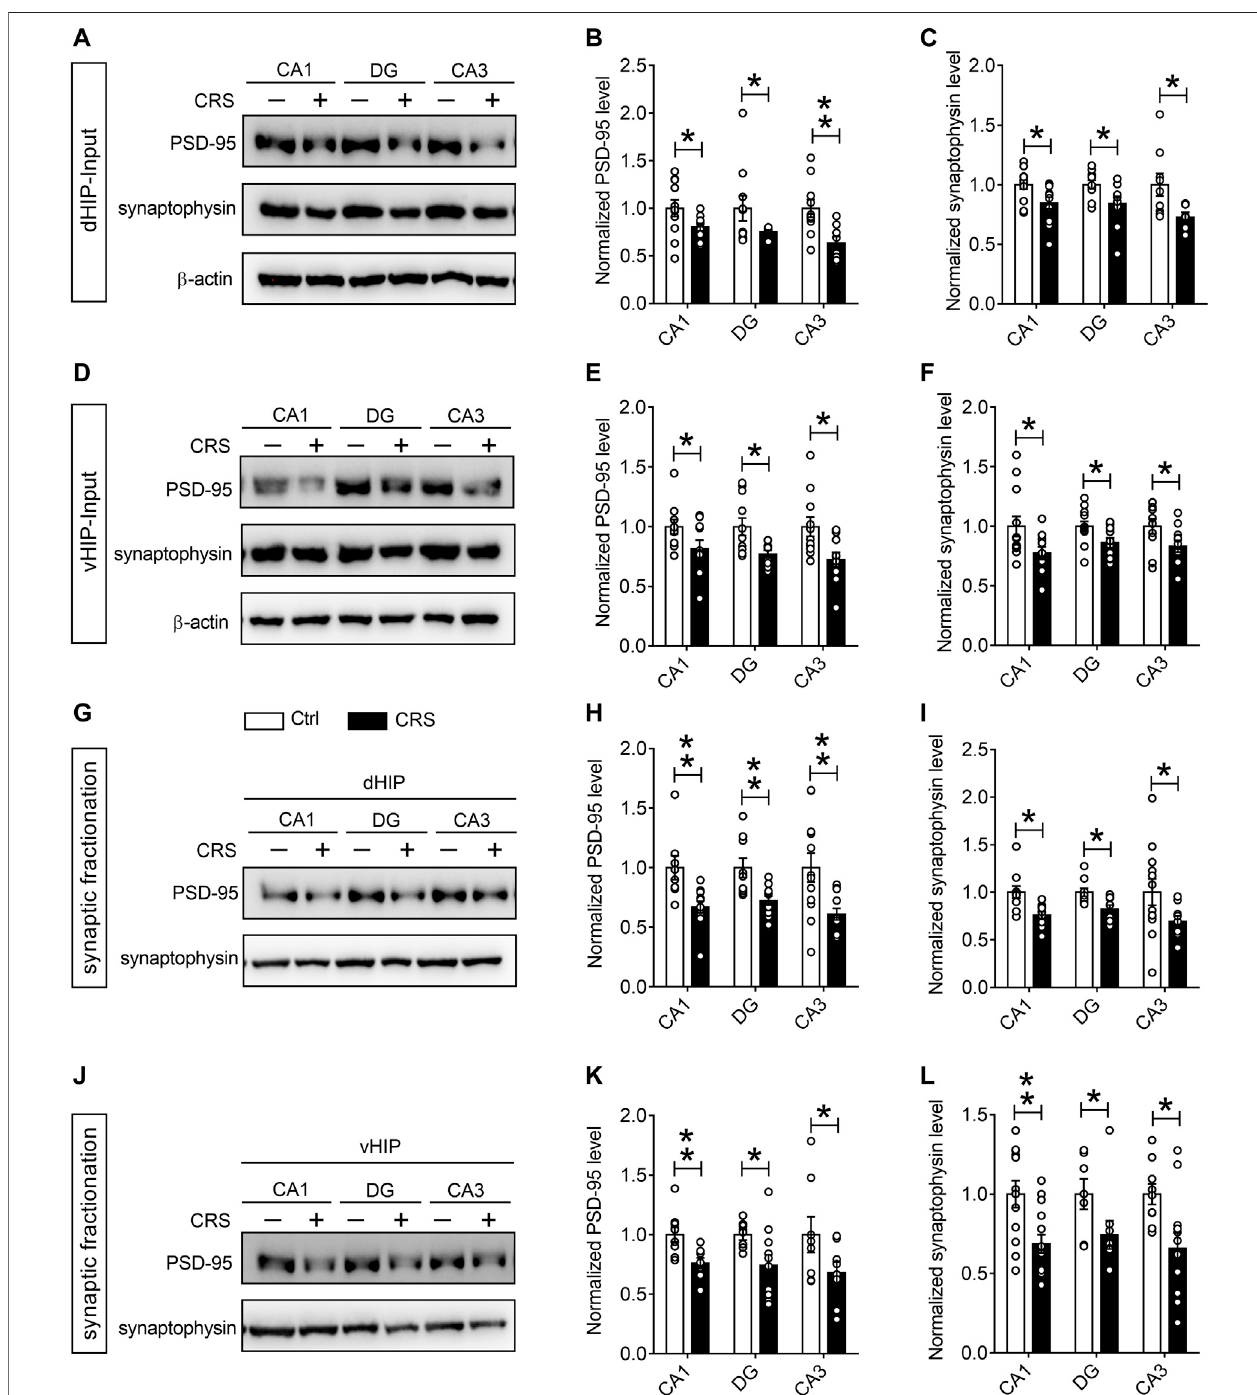
FIGURE 3 | CRS mediates remarkable synapse losses in the hippocampus. (A – C) CRS decreased the expression of PSD-95 and synaptophysin in the CA1, DG, and CA3 regions of dHIP; representative Western blots (A) , statistical analysis of PSD-95 (B) and synaptophysin (C) . (D – F) CRS reduced the PSD-95 and synaptophysin expression in the CA1, DG, and CA3 of vHIP; representative Western blots (D) , statistical analysis of PSD-95 (E) and synaptophysin (F) . CRS induced synapse loss in the CA1, DG and CA3 of dHIP (G – I) and vHIP (J – L) ; representative Western blots (G, J) , statistical analysis of PSD-95 (H, K) and synaptophysin (I, L) . Data are presented as mean ± SEM. One-way ANOVA for all. n (cid:1) 10 – 9 per group for (A – F) , n (cid:1) 8 – 9 per group for (G – L) . * p < 0.05, ** p < 0.01 vs. Ctrl group.